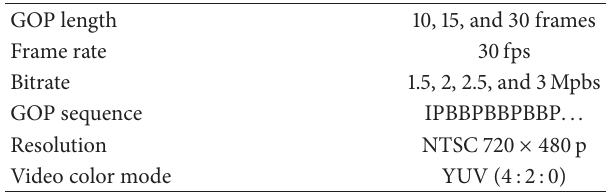
Table 4: Encoder parameters.